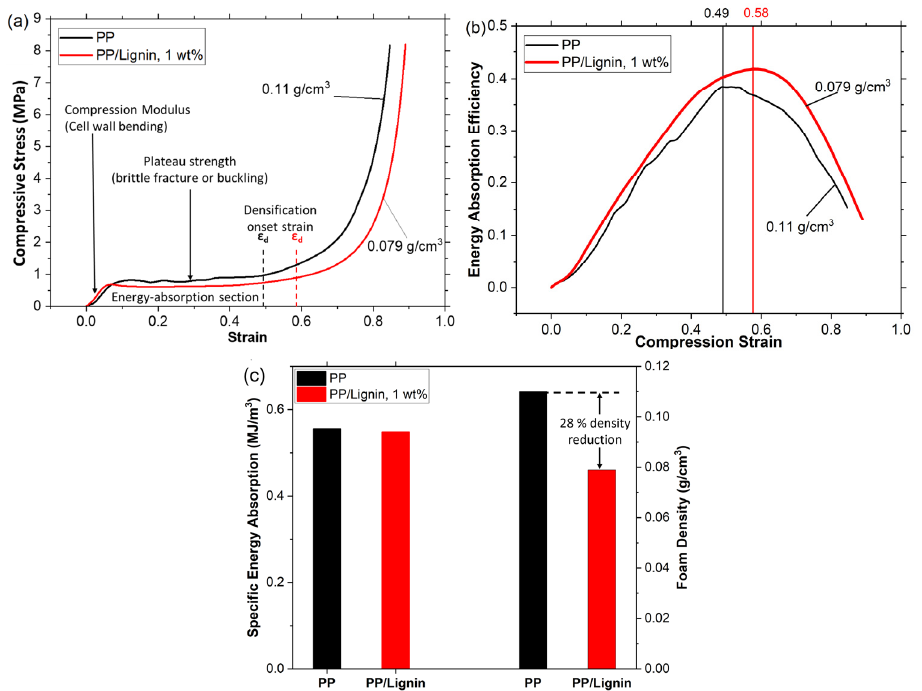
Figure 7. ( a ) Compression curves, ( b ) energy absorption efficiency, and ( c ) specific energy absorption (left) and density (right) of the PP and PP/lignin-1% foams.